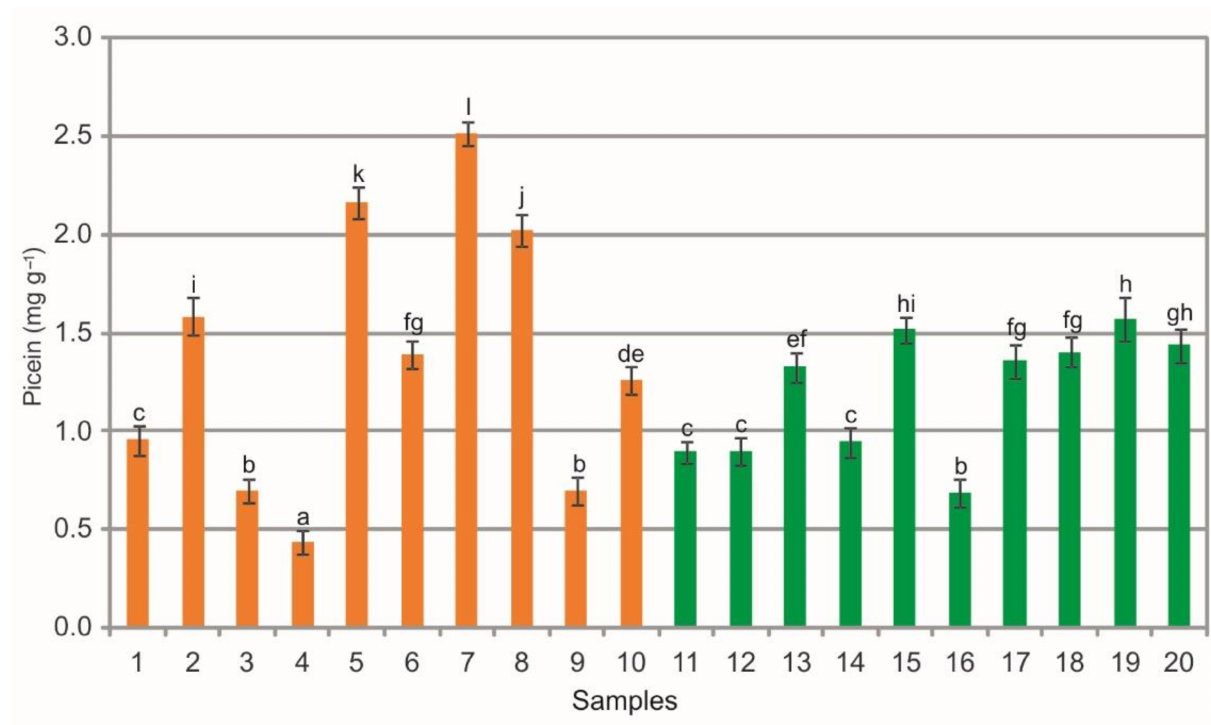
Figure 7. Picein contents (mg g − 1 ) in leaf extracts from bearberry plants collected in heathland populations (orange) and in pine forest populations (green). For each site, data are mean and SD. The values designated by the different letters are significantly different (Tukey test, p <